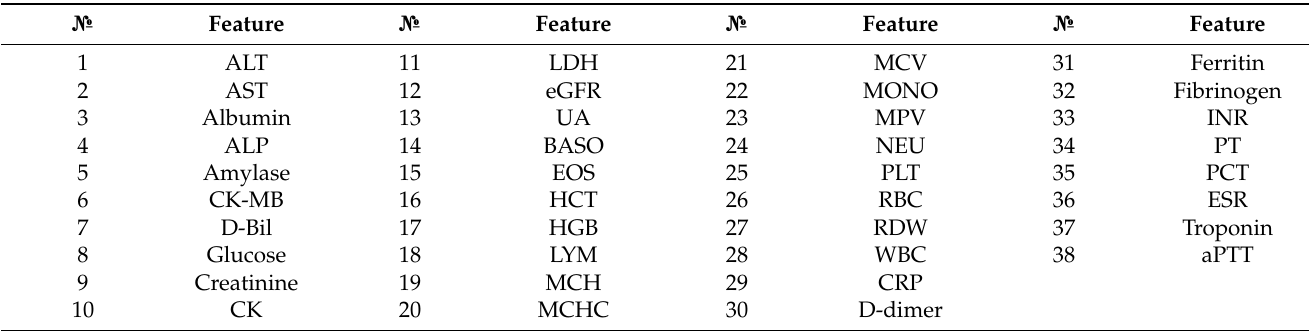
Table 1. Feature-numbering for SARS-CoV-2-RBV3